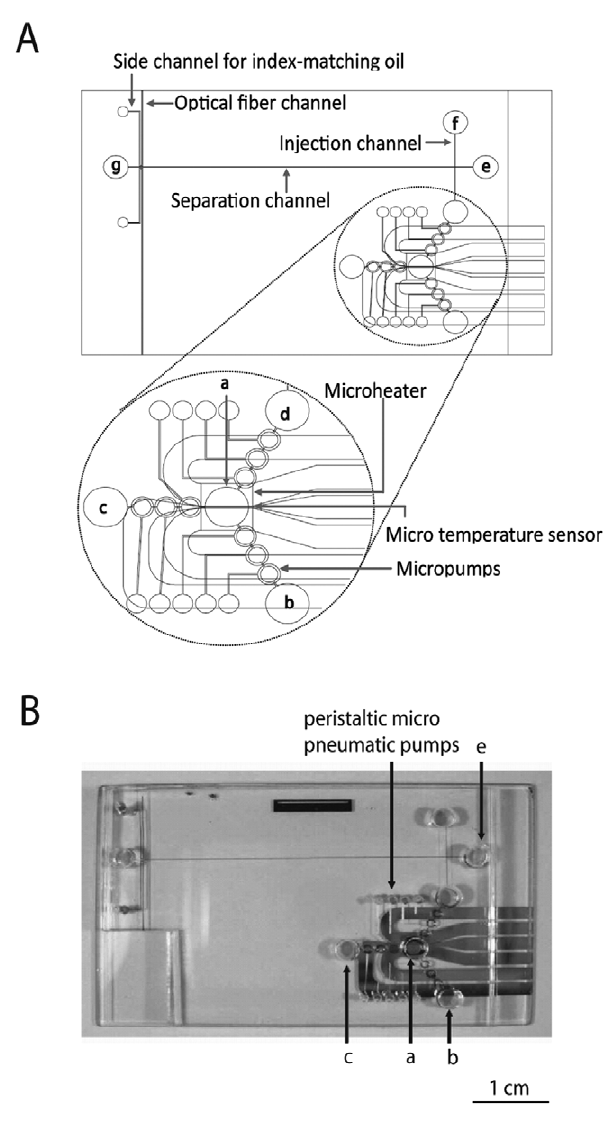
Figure 1. Design of integrated microfluidic chip. A. Schematic diagram of the integrated microfluidic chip. The micro RT-PCR module, capillary electrophoresis (CE) module and buried optical fibers were integrated; (a), reaction chamber; (b), RT reagent reservoir; (c), PCR reagent reservoir; (d), sample reservoir; (e), CE sample reservoir; (f), buffer reservoir; (g), waste collection chamber. B. Photograph of the microfluidic chip. The 3 layers of the integrated chip are composed of a polymethylmethacrylate (PMMA) CE chip, a glass micro PCR chip, and Polydimethylsiloxane (PDMS) micropumps. The dimension of chip is 6.5 6 3.9 6 0.8 cm 3 . The CE channel is 100 m m in width 6 30 m m in depth. The volumes of the PCR and reagent chambers are 11.25 m L.